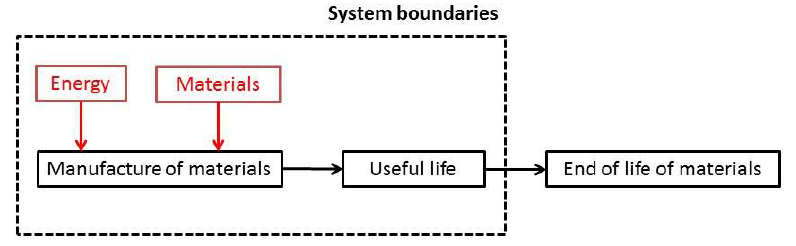
Figure 2. PEMFC system boundaries considered in the LCA.